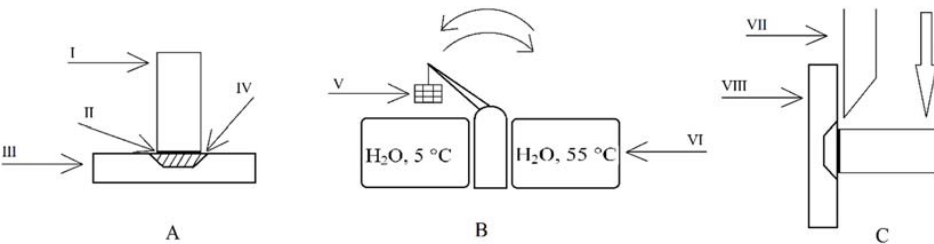
Figure 7. Schematic illustration of the sample preparation, thermocycling and shearing: ( A ) ceramic cylinder cemented onto human dentin embedded in an acrylic retainer; ( B ) thermocycling; ( C ) shear bond strength measurement; I ‐ ceramic cylinder; II ‐ resin luting cement. III and VIII ‐ acrylic dentin slice retainer; IV ‐ slice of human dentine; V ‐ basket with thermocycled samples; VI ‐ distilled water baths; VII ‐ shear knife of the universal testing machine.